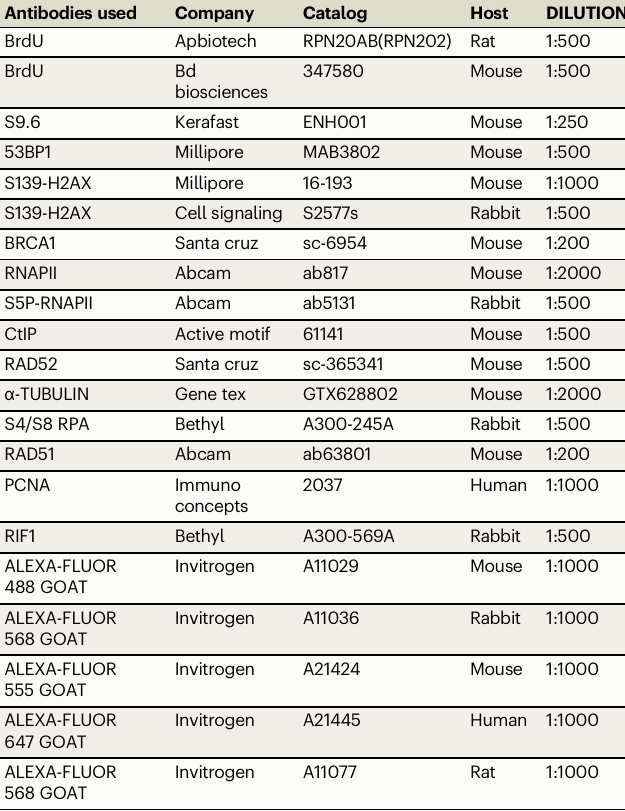
Table 1 | List of antibodies Antibodies